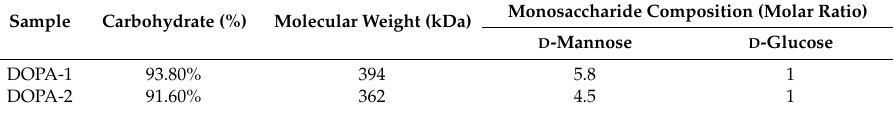
Table 1. Contents of carbohydrate and monosaccharide compositions for polysaccharide fractions from D. officinale